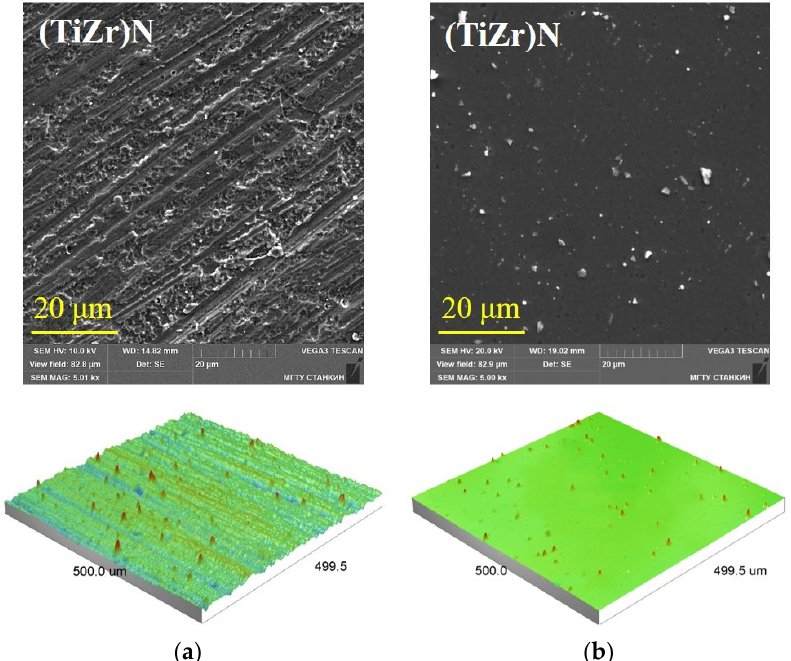
Figure 7. SEM images of the microstructure and 3D profilogram of (TiZr)N coatings deposited on Al 2 O 3 +TiC ceramic inserts with different surface layer conditions after diamond grinding ( a ) and after diamond grinding, lapping and polishing ( b ).